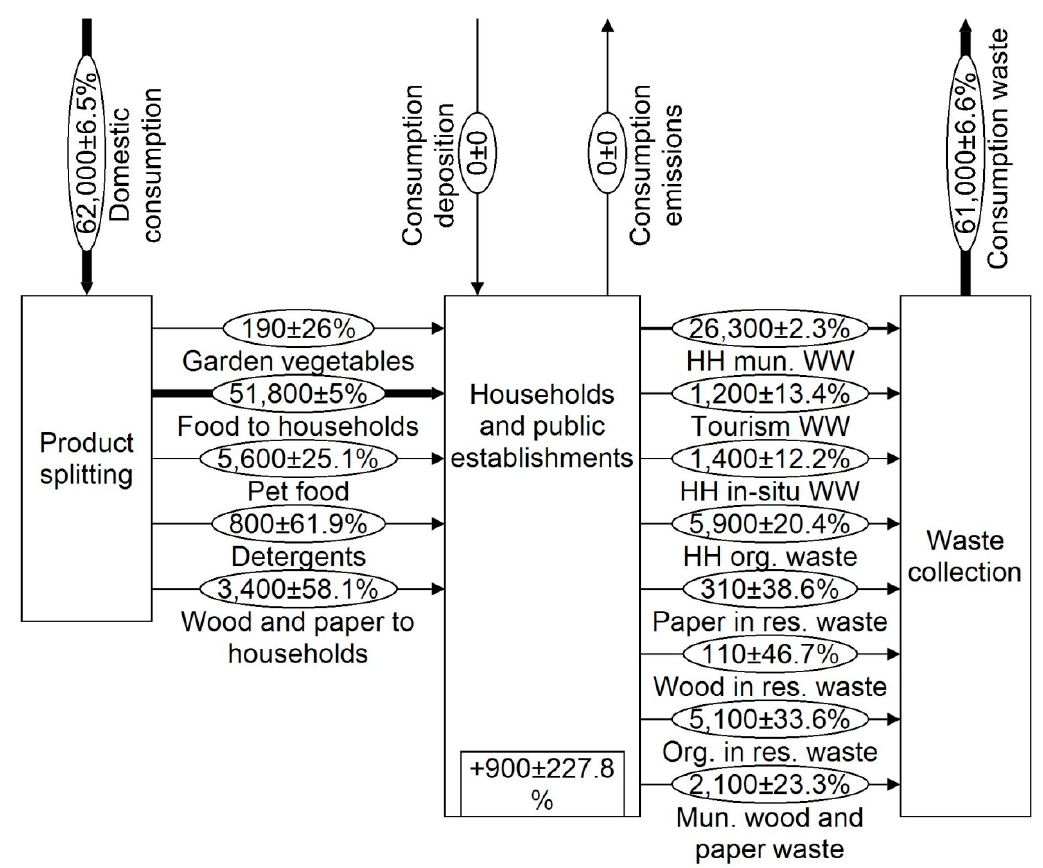
Figure A5. Austrian N system 2015, subsystem use.